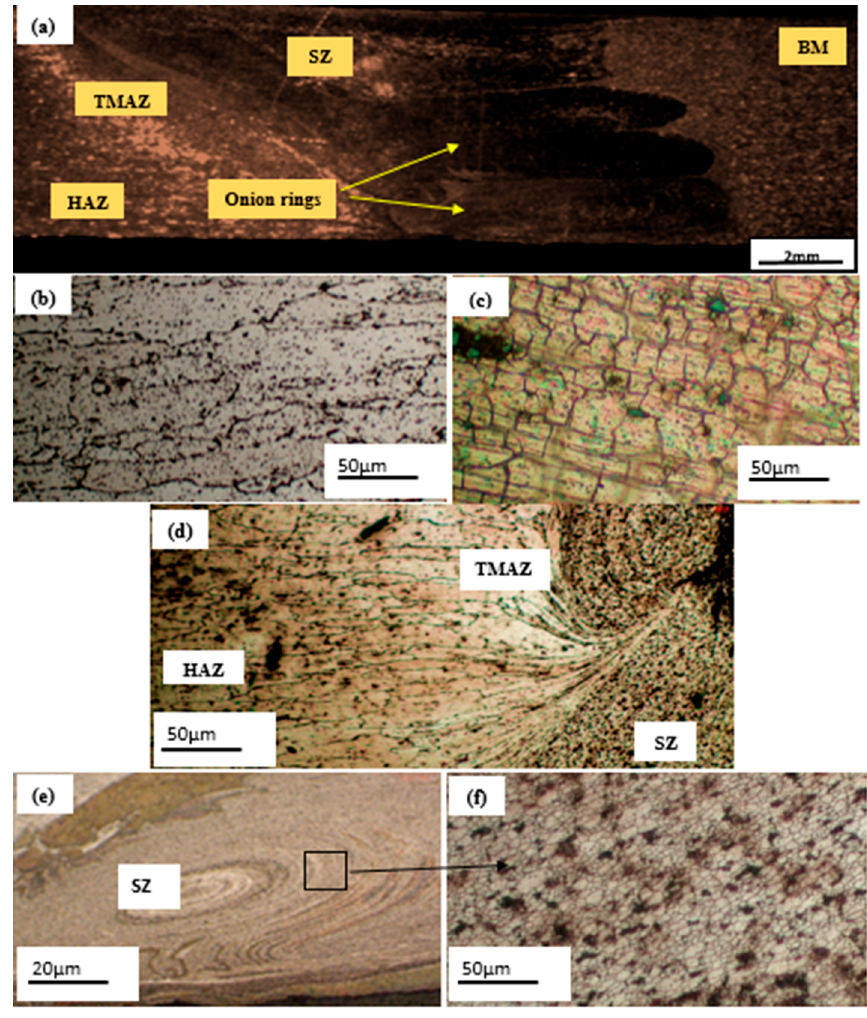
Figure 9. ( a ) Macrostructure of the welded joint; ( b ) microstructure of AA1050-H14; ( c ) microstructure of AA5083-H111; ( d ) thermo-mechanical affected zone; ( e ) stir zone; ( f ) grains of the stir